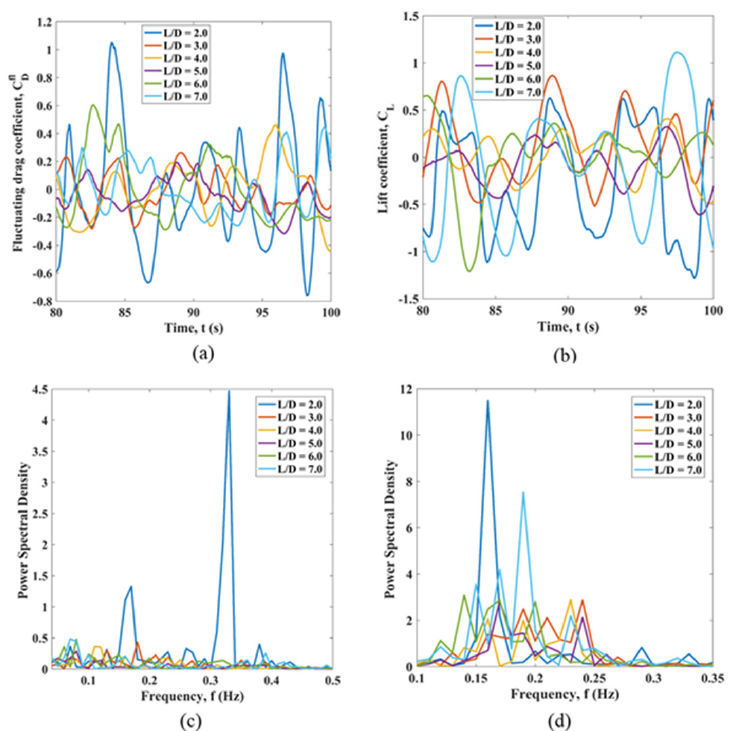
Figure A2. Fluid force coefficients for cylinder 3 immersed in the uniform flow: ( a ) time history of the fluctuating drag coefficient; ( b ) time history of the lift coefficient; ( c ) the drag coefficient FFT; ( d ) the lift coefficient FFT.